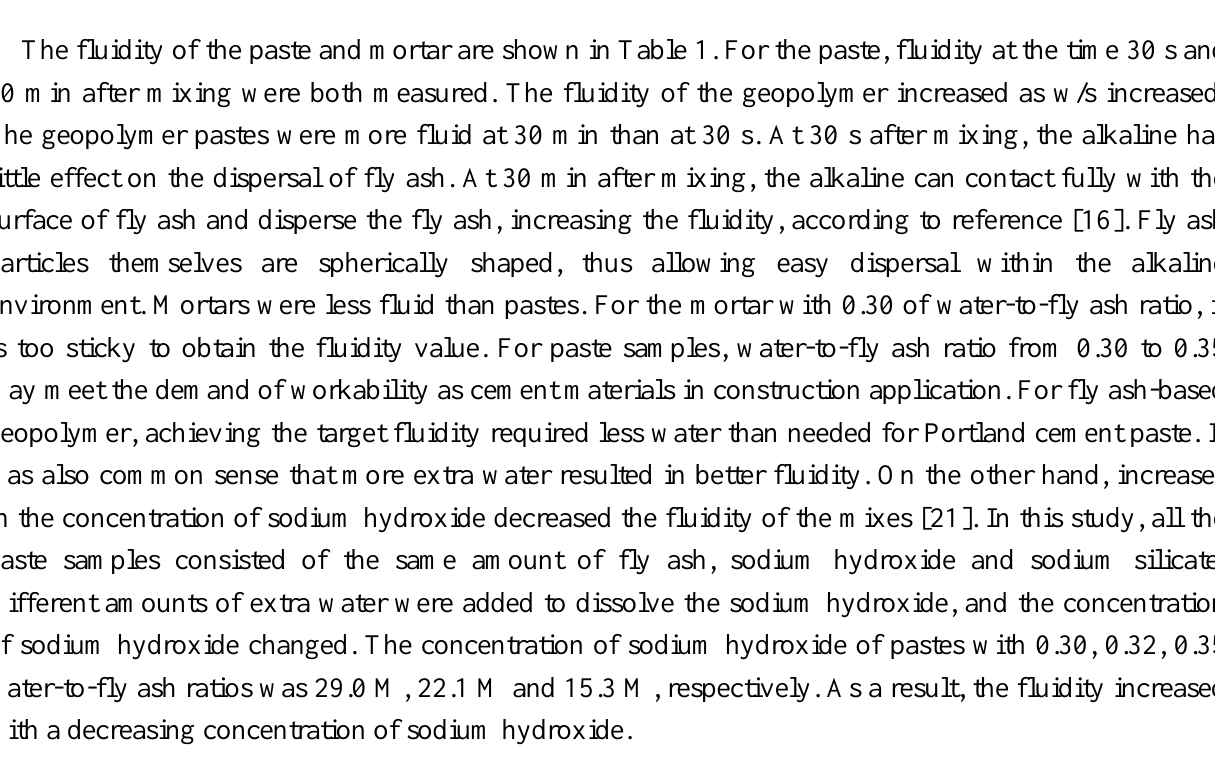
Table 1. Fluidity of geopolymer with different water-to-fly ash